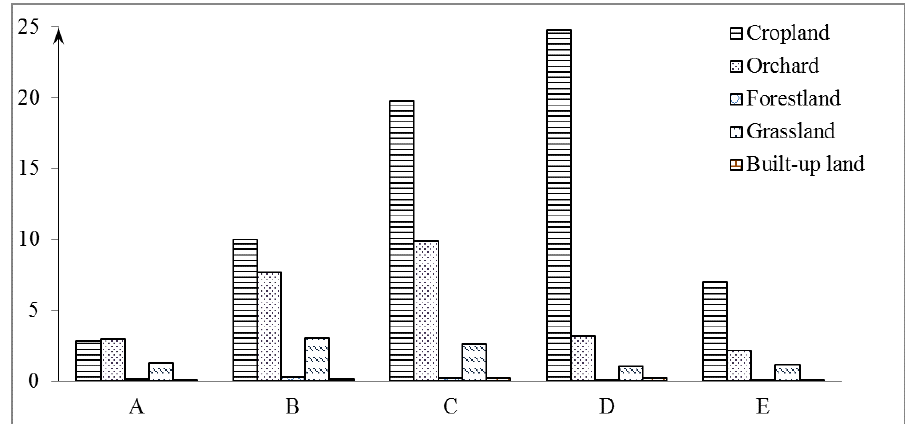
Figure 9. The proportion of the land use suitability area of different land use patterns (the proportion of the land use suitability grade is divided into A – E in Figure 8: (A) most suitable; (B) highly suitable; (C) moderately suitable; (D) marginally suitable; and (E) least suitable).